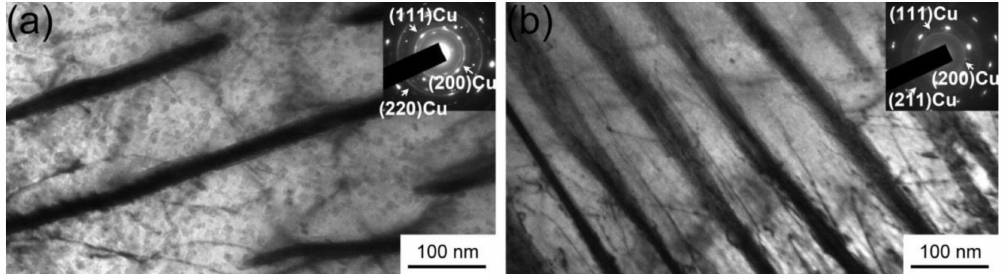
Figure 9. Copper precipitates in the specimens cooled at ( a ) 0.5 ◦ C / s and ( b ) 7 ◦ C / s after aging at 400 ◦ C for 2 h.